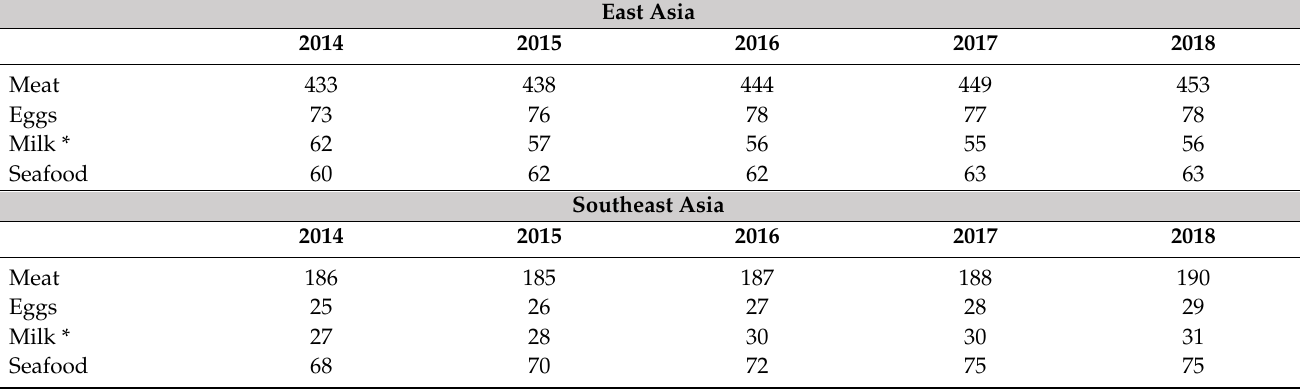
Table 8. Animal-based food available for consumption in East and Southeast Asia